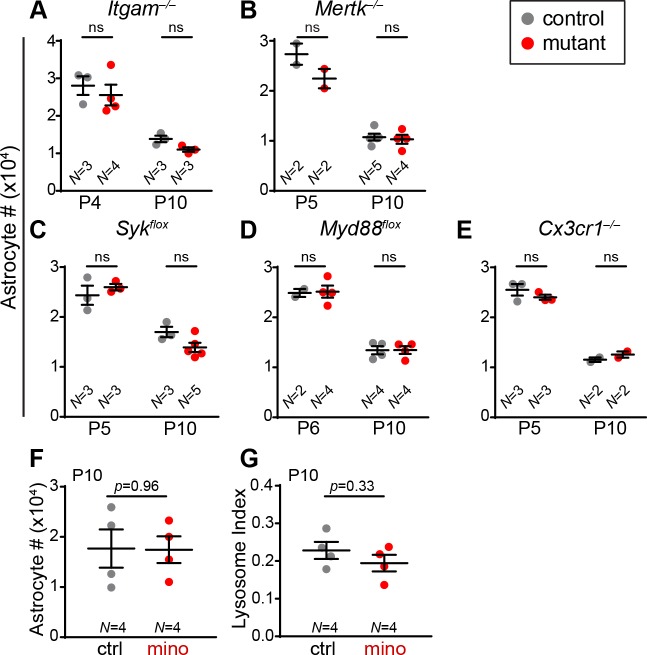
Blockade of major phagocytosis pathways does not affect astrocyte number.(A-E) Total astrocyte numbers were determined in mutant mice (red) and littermate controls (gray) at two ages during the astrocyte death period. (A) Itgam constitutive null mutants lack the complement C3 receptor. (B) Mertk constitutive null mutants lack Mer tyrosine kinase receptor. (C,D) Sykflox (C) and Myd88flox (D) are conditional alleles of signaling components downstream of FcγR/TREM2 (C) or Toll-like receptors (D). Mutants carried Cx3cr1CreER (C) or Cx3cr1-Cre (D) to drive microglia-specific gene deletion. (E) Cx3cr1CreER/CreER constitutive null mice lack fractalkine receptor. Statistics: for each data set, two-way ANOVA was performed; none resulted in significant main effects of genotype on astrocyte number (see S1 Table for ANOVA details). (F,G) No effect of minocycline on total astrocyte numbers (F) or microglial phagocytic capacity (G). Administration, P4–P9; analysis, P10. Statistics: two-tailed t tests. Error bars, mean ± SEM. For data plotted in graphs, see S1 Data. ctrl, control; mino, minocycline; ns, not significant.